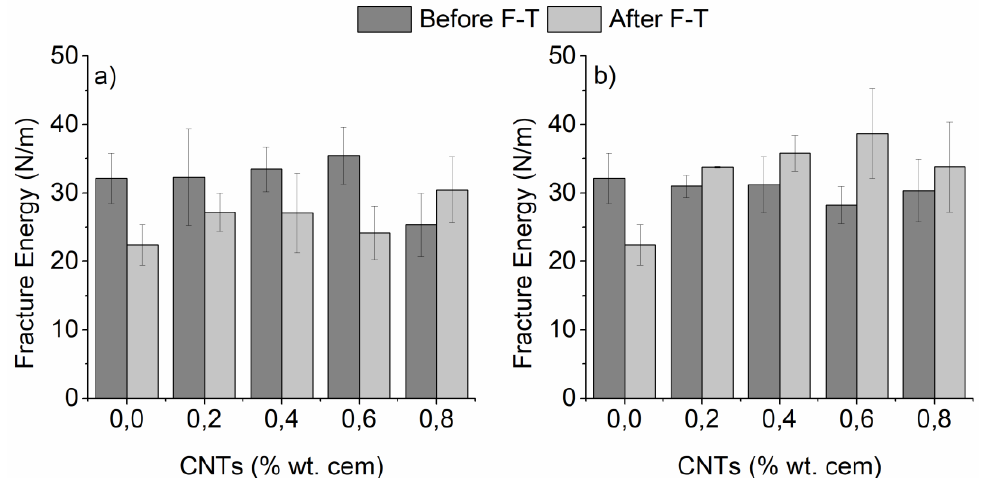
Figure 5. Fracture energy of nano-mortars prepared with ( a ) superplasticizer and ( b ) surfactant as dispersive agent, as a function of F-T exposure (plain specimens have been added for reference).